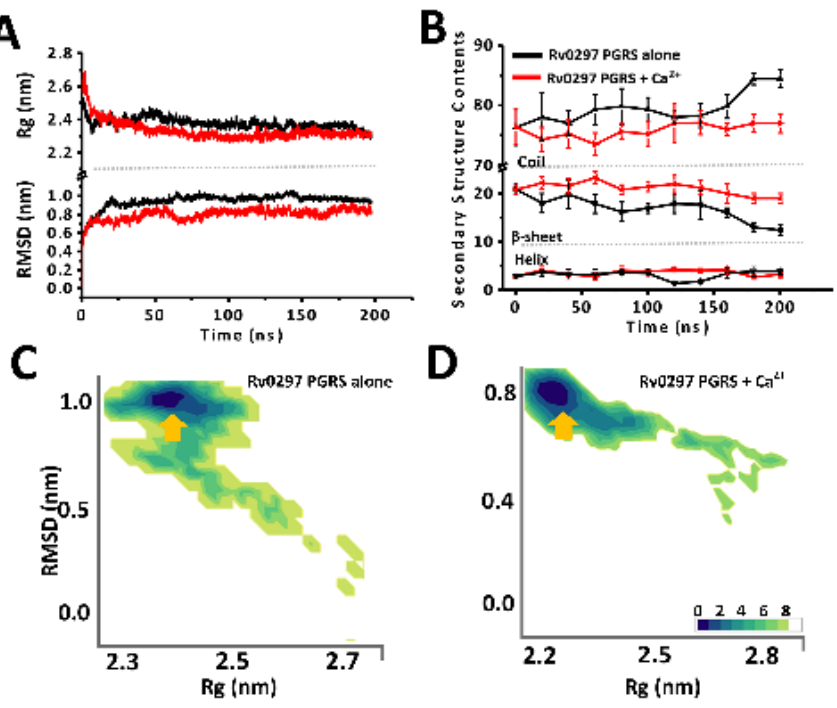
Figure 2. Molecular dynamics (MD) simulation outcomes of Rv0297PGRS alone and in the presence of calcium ions. ( A ) Variations in backbone RMSD and C α gyration radius along the 200 ns trajectory and ( B ) Transitions in secondary structure elements of both systems, obtained after simulations of Rv0297PGRS alone (Black) and in presence of Ca 2+ ions ( C , D ) Free energy landscapes (in kJ/mol) pro- jected onto backbone RMSD and gyration radius (Rg) averaged over the whole simulation trajectory, for Rv0297PGRS alone and in presence of Ca 2+ ions, respectively. Arrows indicate low free energy basins corresponding to metastable stables thata are achieved by Rv0297PGRS in both